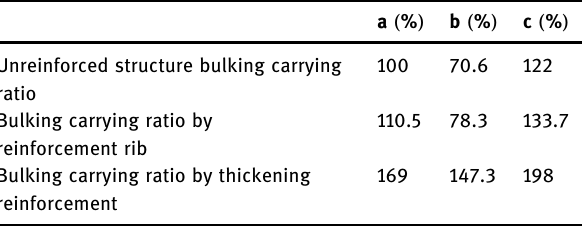
Table 4: Comparison of the relative buckling load